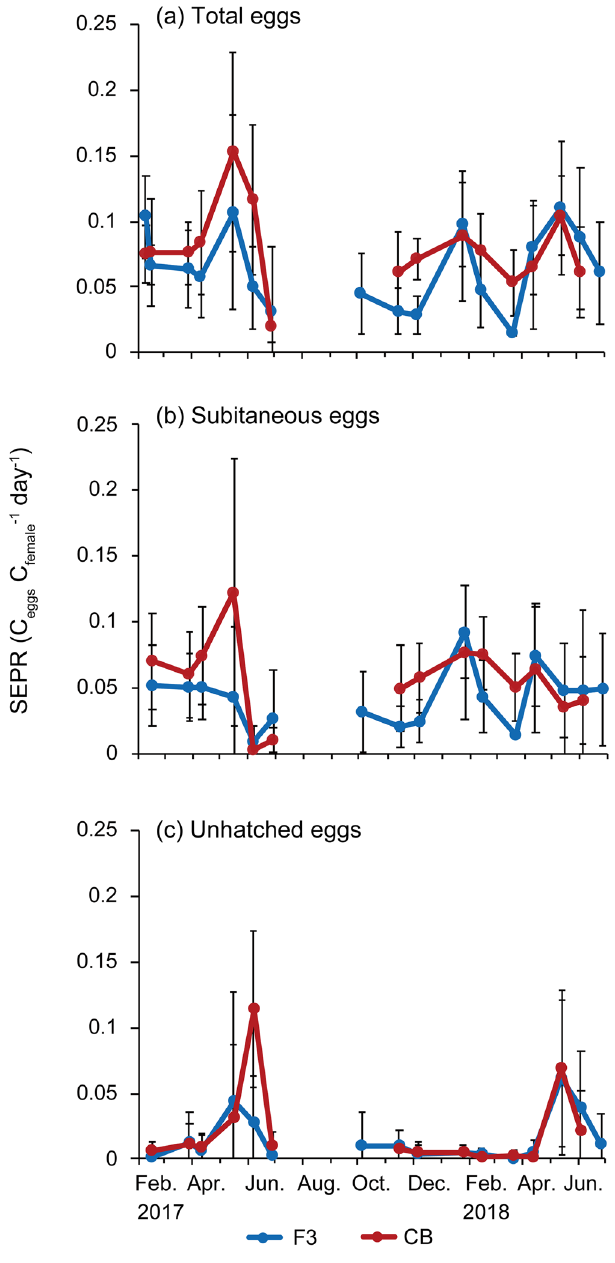
Figure 8. Seasonal changes in ( a ) total weight-specific egg production rate (SEPR), ( b ) Subitaneous SEPR and ( c ) Unhatched SEPR of Acartia omorii at St. F3 and St. CB from February 2017 through June 2018. Error bars denote ±